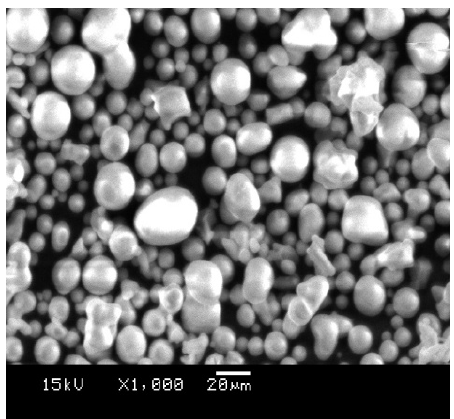
Figure 3. The microscopic morphology of the